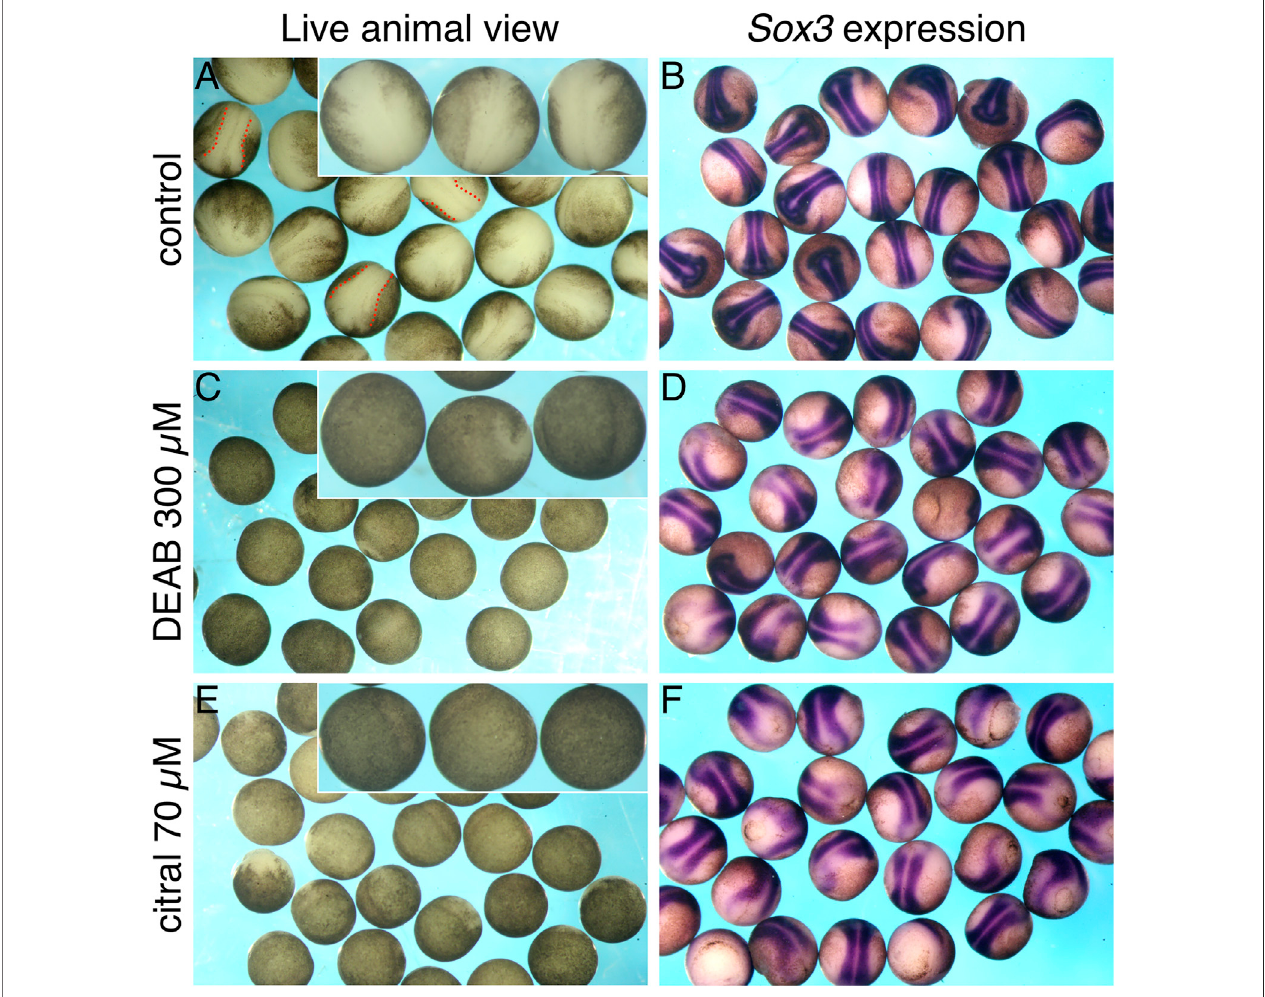
FIGURE4| ReducedRAsignalingaffectstheapparentlocationoftheneuralplate.EmbryosweretreatedwithDEABorcitraltoinhibitthebiosynthesisofRA.Atst. 15, embryos were analyzed for the formation of the neural plate while alive by visual examination (A,C,E) , or after in situ hybridization with the neural plate marker, sox3 (B,D,F) . (A,B) Control embryos (n = 25). (C,D) Embryos treated with DEAB (300 μ M; n = 23). (E,F) Treatment of embryos with citral (70 μ M; n = 26).